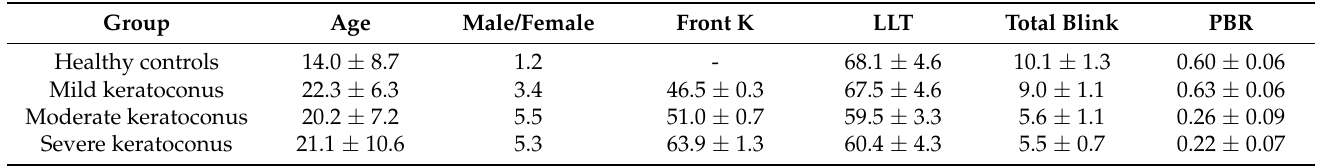
Table 1. Baseline characteristics of the enrolled subjects.